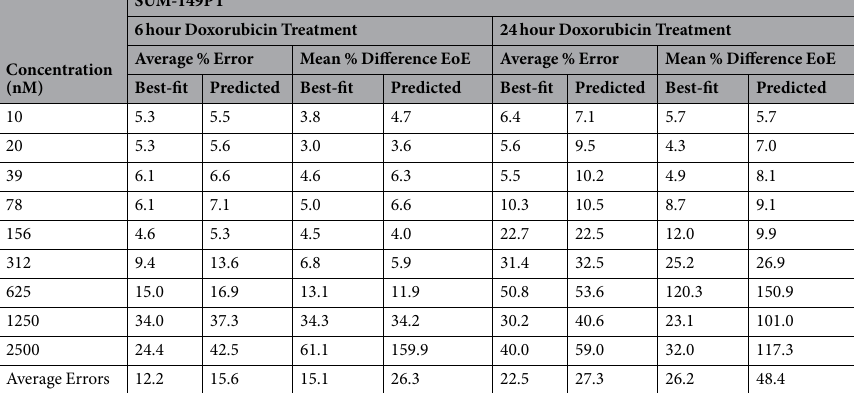
Table 1. Table of model statistics for SUM-149PT cell line following 6 and 24 hours of treatment with doxorubicin.